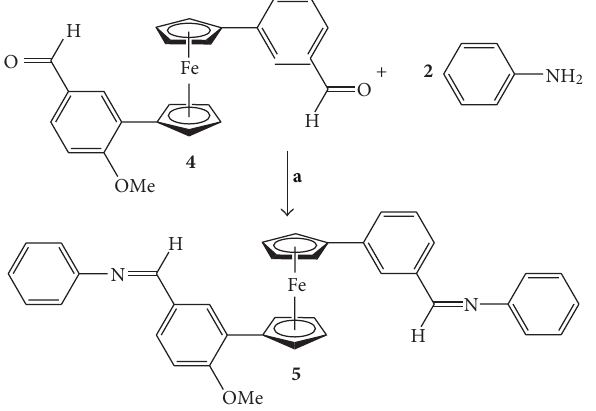
Scheme 2: Synthesis procedure of model compound 5 . Reagents and conditions: (a) EtOH, piperidine, reflux. Table 1: Room-temperature solubility characteristics of Fc-polya-